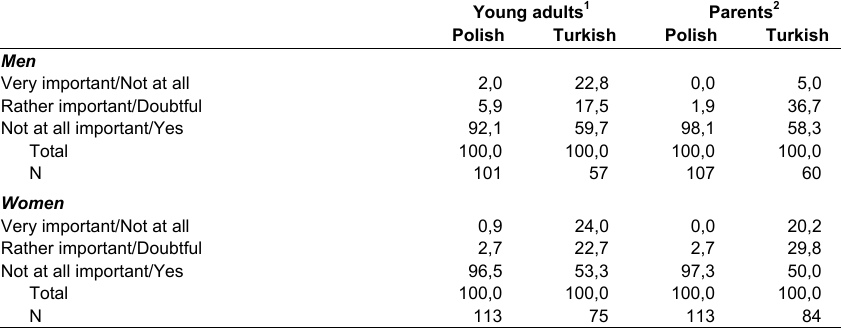
Table 4. Attitudes toward endogamy among young adults by origin and